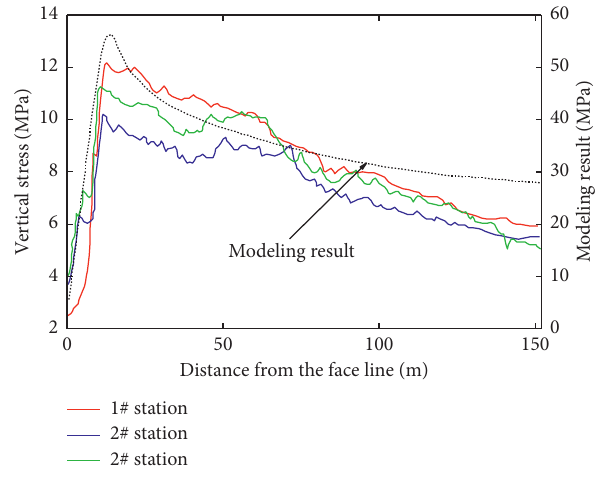
Figure 4: Vertical stress distribution.